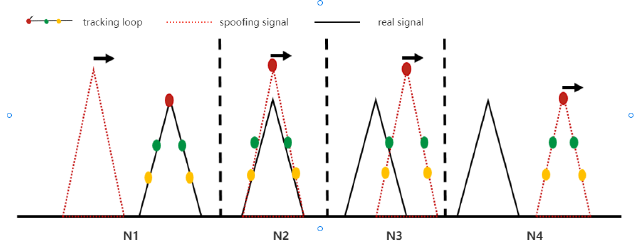
Figure 8. Schematic diagram of sliding self-synchronization mode of spoofing attack in tracking stage. N1: Align the phase of the spoofing signal number with the real signal; N2: Carrier ring of control receiver; N3: Introduce code phase change to spoofing signal; N4: Properly reduce the power of spoofing signal and complete the tracking loop control of